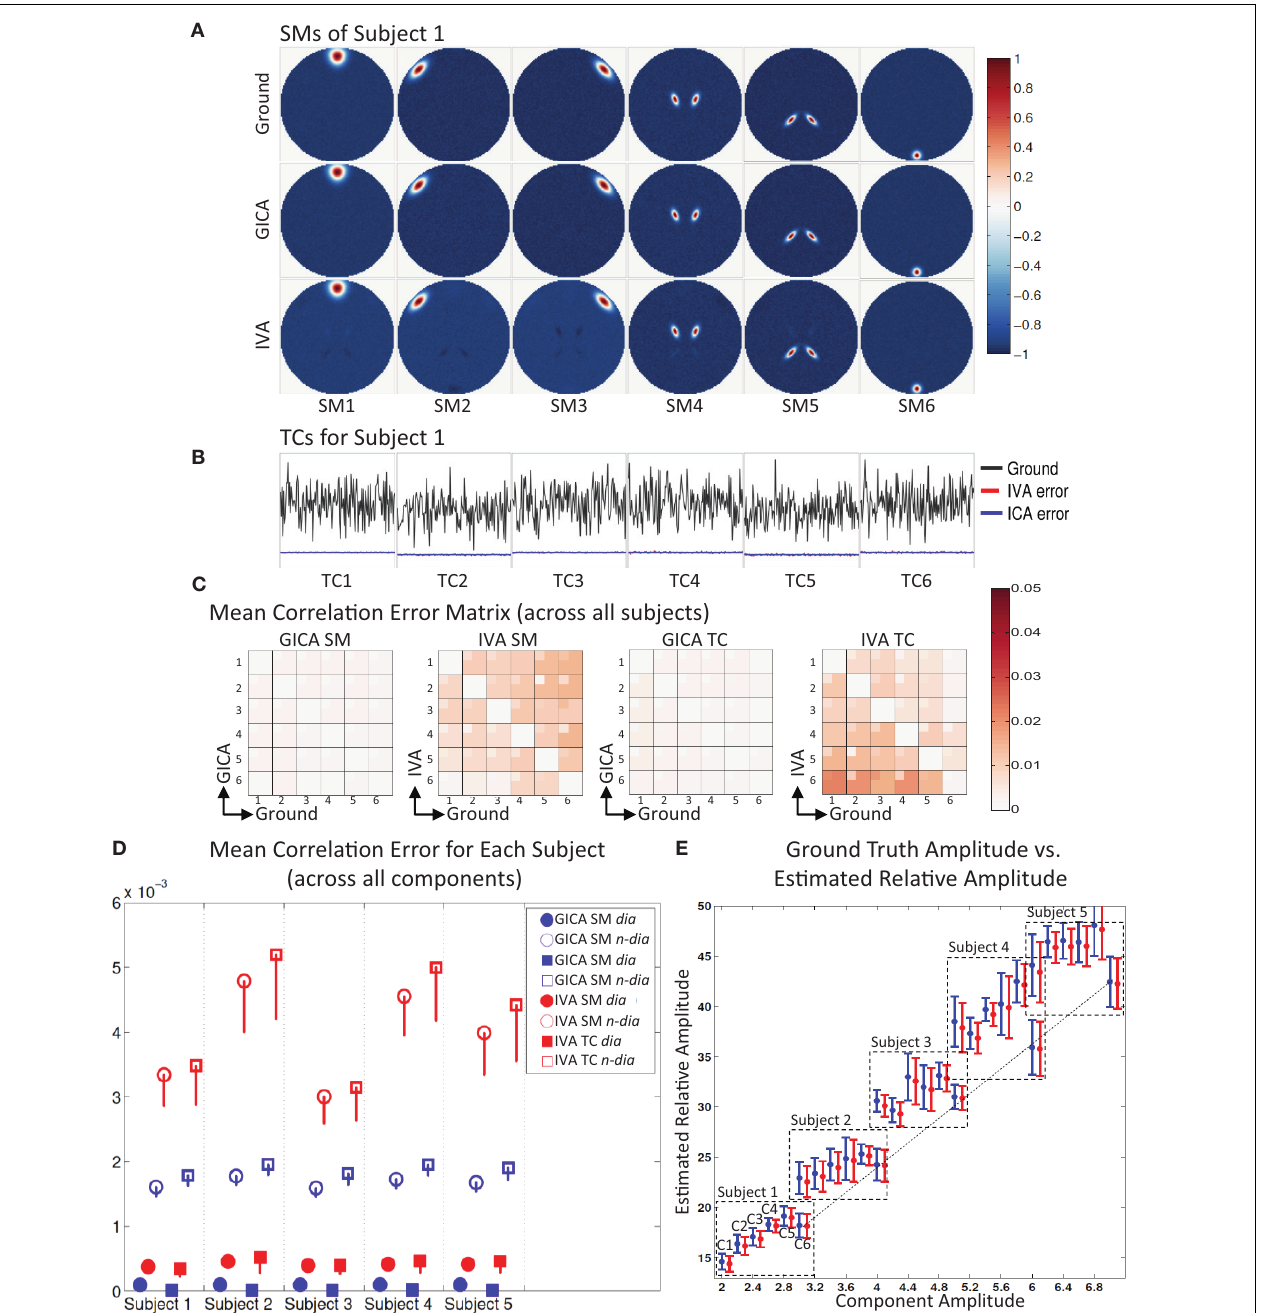
FIGURE 2 | Results ofExperiment 1:Estimation accuracy withvariation in only the Amplitude of SMs (no spatial variability of components). (A) Spatial Maps (SM) of subject 1: 6 Ground SMs, GICA SM estimates, and IVA SM estimates are respectively presented in different rows. All SMs are scaled between − 1 and + 1. SMs of Subjects 2–5 are very similar to Subject 1. SMs show that both GICA and IVA perform very good estimations (IVA estimations had minor artifacts). (B) Time Courses (TC) of Subject 1. TCs are normalized to zero mean unit variance. Under each TC the error (shifted for better representation, but scale unchanged) between the estimates and ground are presentedinblueforGICAandredforIVA.ComparedtogroundTC,therelative magnitudes of the errors are very small. (C) Mean correlation error matrix